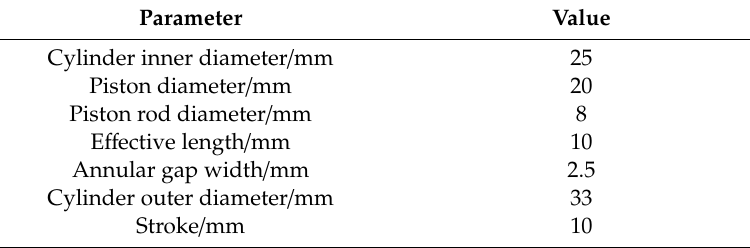
Figure 5. Magnetization characteristic curve of the MR fluid. Table 2. Main structure dimensions of the MR buffer.